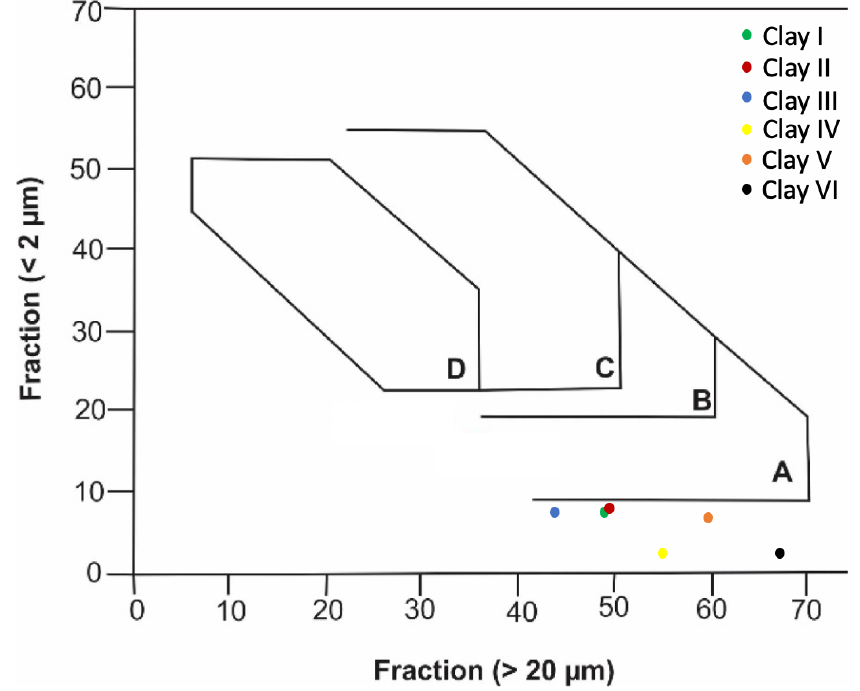
Figure 11. Suitability of clays studied for different ceramic products according to Winkler’s diagram .